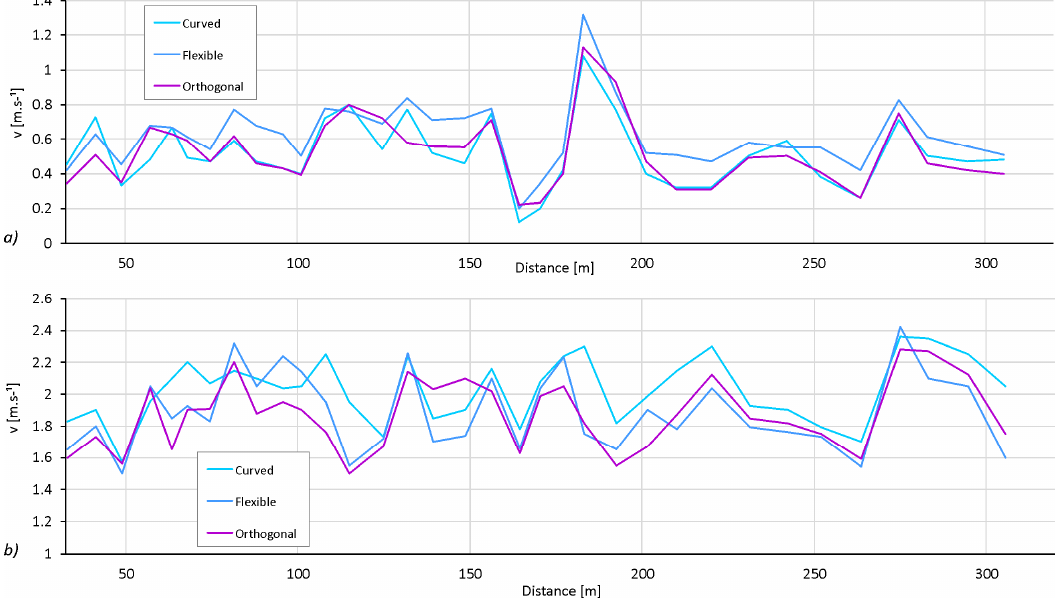
Figure 12. Longitudinal profile of flow velocities on the main flow path and characteristic cross-sections. ( a ) Average flow (0.3 m 3 ·s − 1 ); ( b ) peak flow of the June 2013 flood (11.7 m 3 ·s − 1 ).